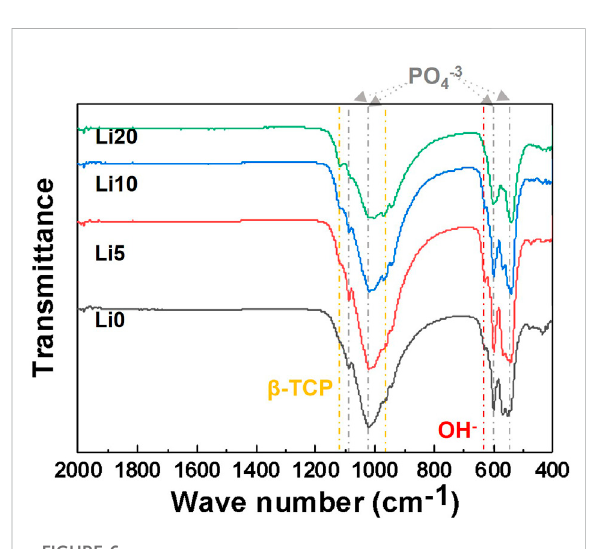
FIGURE 6 FT-IR spectra of the pure BCP and Li-BCP powders after calcined at 1,000 °